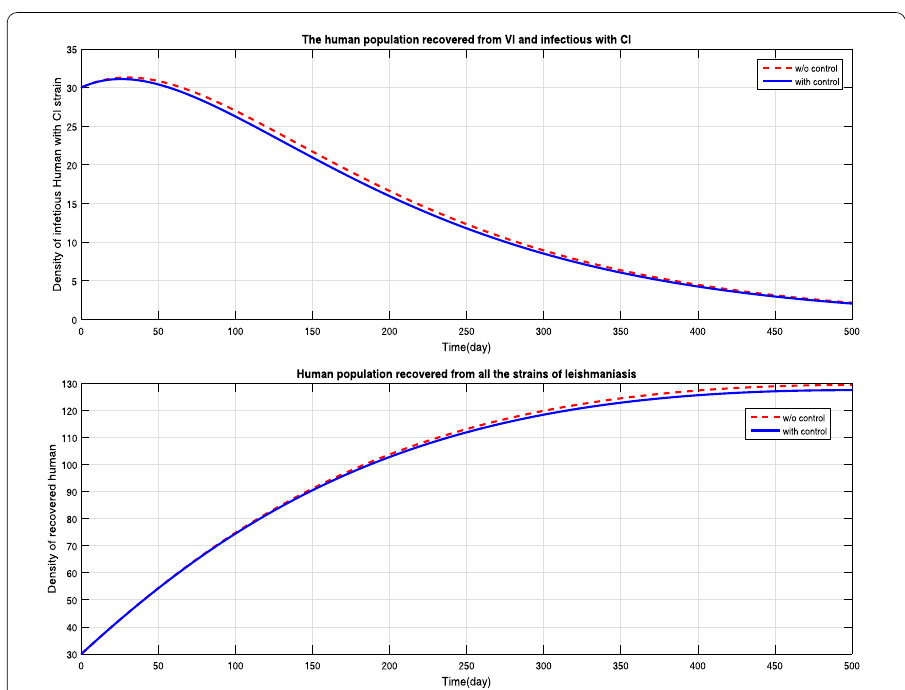
Figure 9 Comparison of behaviors with and without control in case of I 21 and M